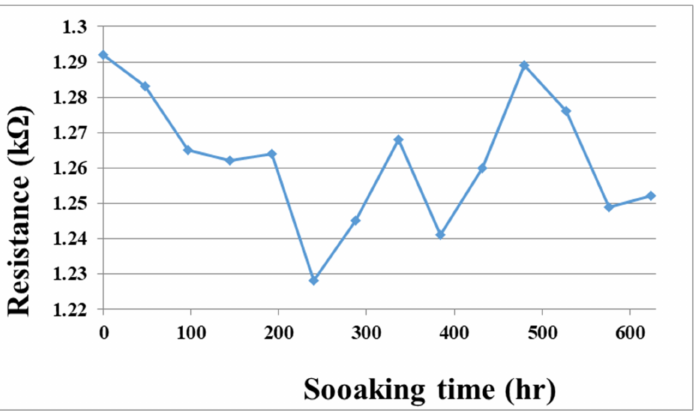
Figure 14. The soaking time and the resistance value of the flexible, multifunctional micro-sensor soaked in vanadium electrolyte.